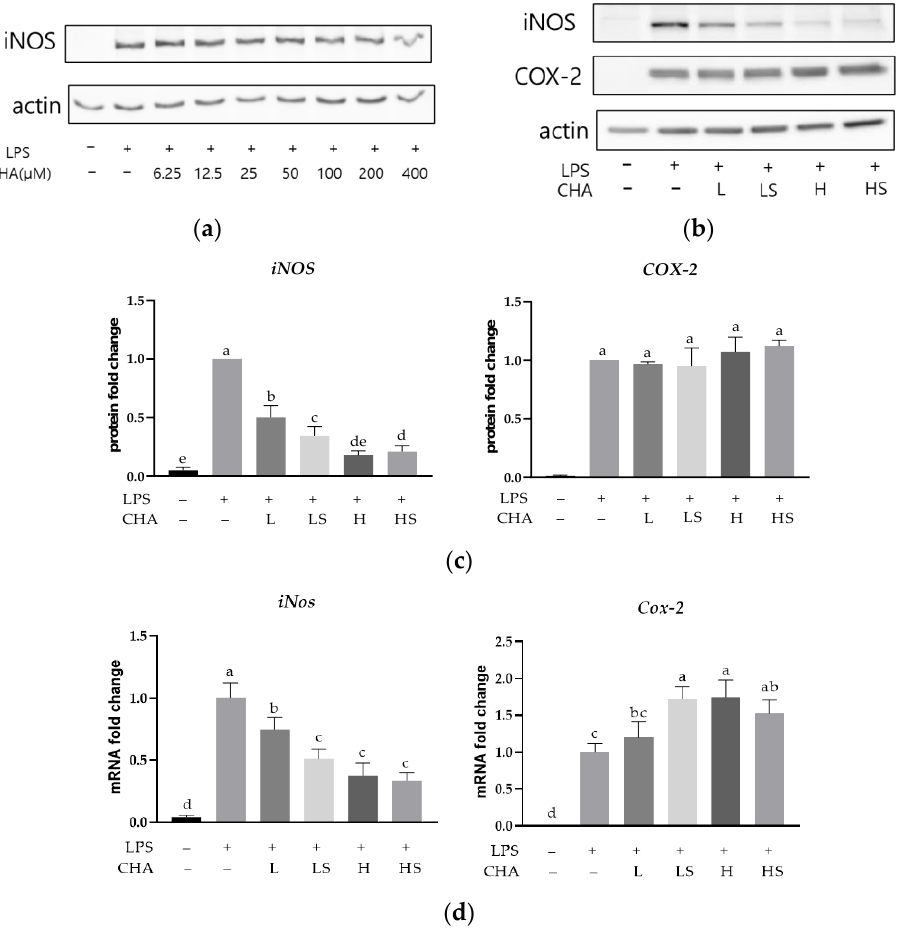
Figure 2. Effect of different delivery models on iNOS and COX-2 expression. ( a ) Cells were treated with a serial concentration of CHA with regular instantaneous delivery. Protein expression of iNOS was determined. ( b ) Low doses and high doses of CHA were delivered to a culture medium using a pipette or syringe pump. Representative images of iNOS and COX-2 protein expression are shown. ( c ) Protein expression levels were quantified. ( d ) mRNA levels of iNos and Cox-2 were measured. Bars without a common letter indicate significant differences ( p < 0.05). CHA: chlorogenic acid; LPS: lipopolysaccharide; iNOS: inducible nitic oxide synthase; COX: cyclooxygenase; L: low dose administered via pipette; LS: low dose administered via syringe pump; H: high dose administered via pipette; HS: high dose administered via syringe pump.